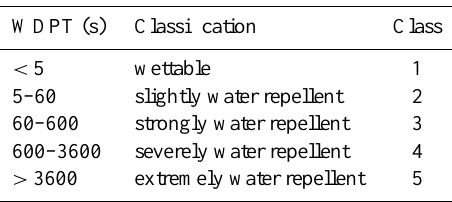
Table 1. Classification of water repellency by WDPT, after Bisdom et al.